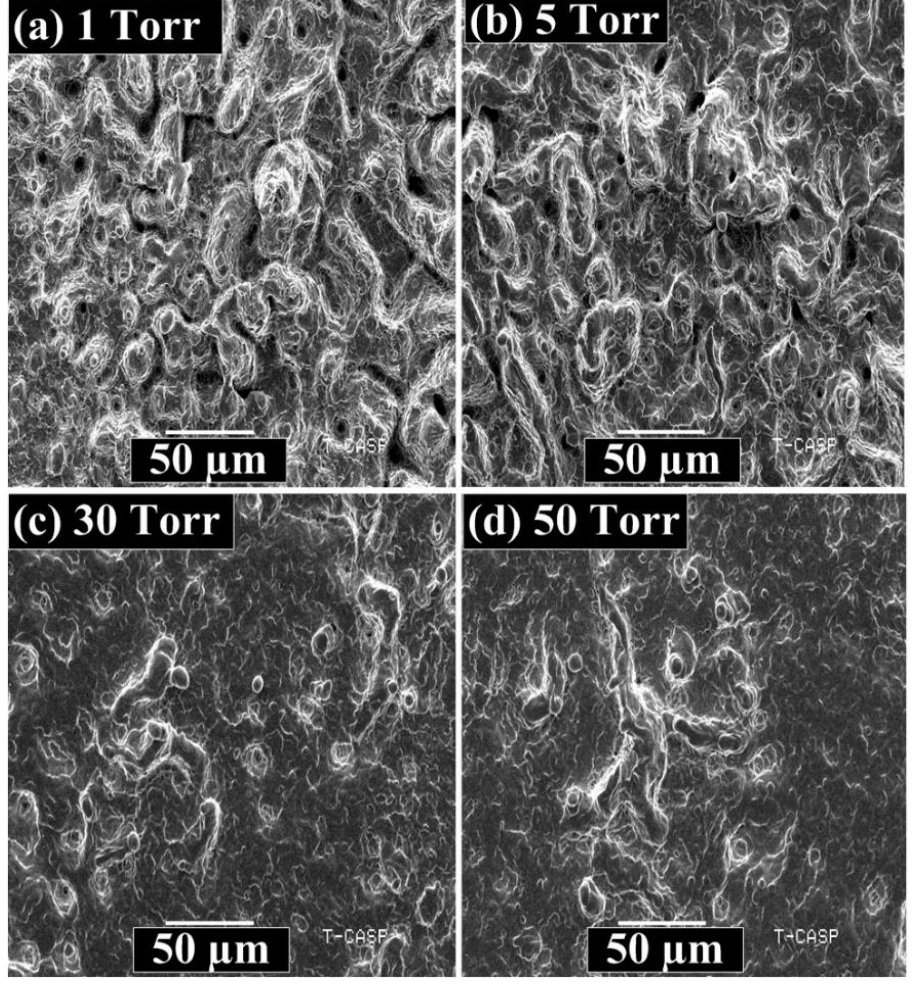
Figure 10. SEM micrographs illustrating surface morphological variations in an Ar ambient environment at various pressures, respectively ( a ) 1 torr, ( b ) 5 torr, ( c ) 30 torr, and ( d ) 50 torr, with a laser irradiation of 3.8 GW/cm 2 in the field-free condition.